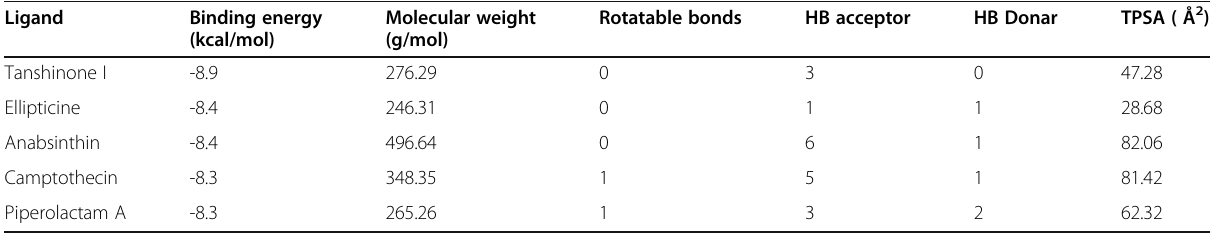
Table 1 Dock Scores obtained from Autodock Pyrex of Screened Ligands Ligand Binding energy